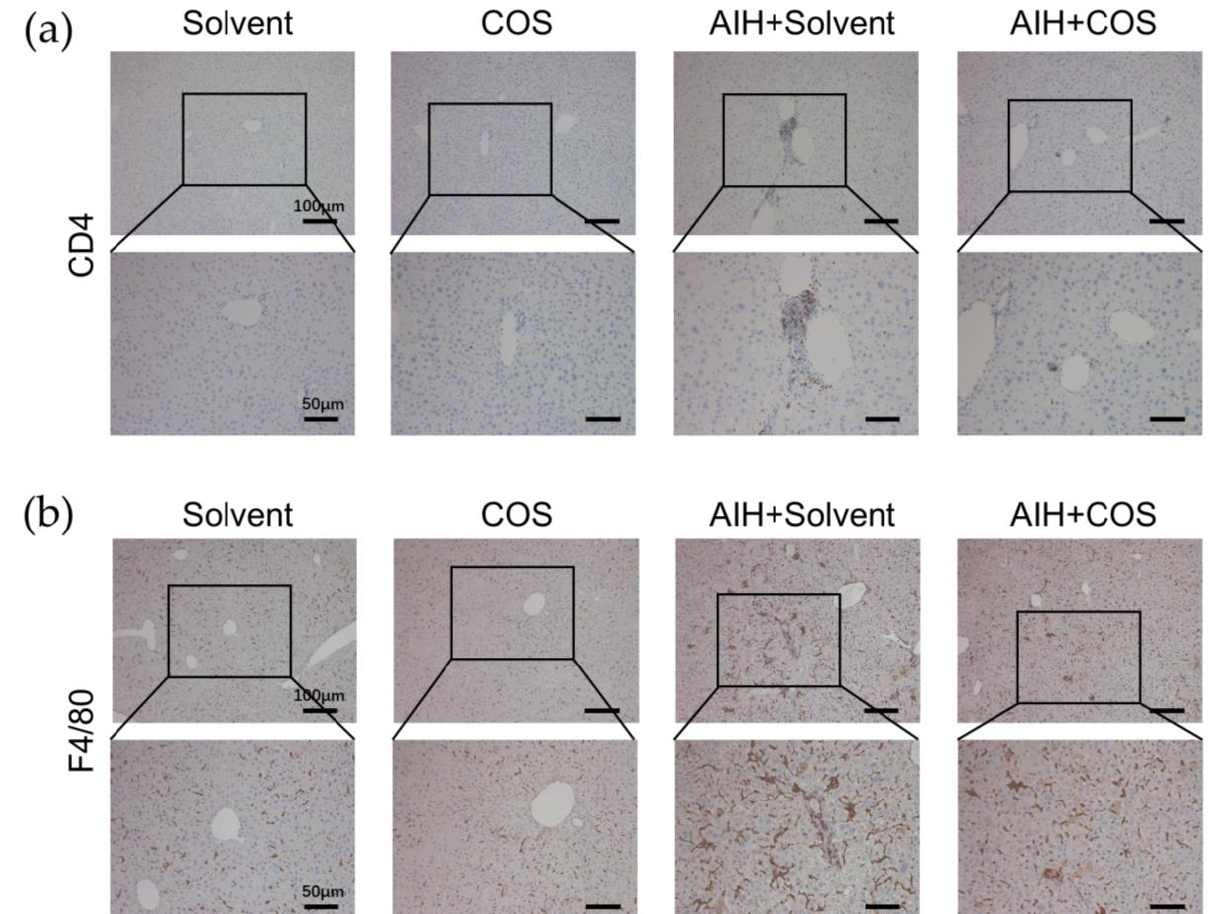
Figure 9. Costunolide inhibited immune cell infiltration in chronic murine autoimmune hepatitis. ( a ) Immunohistochemistry of CD4 + T cells. ( b ) Immunohistochemistry of F4/80 + macrophages.